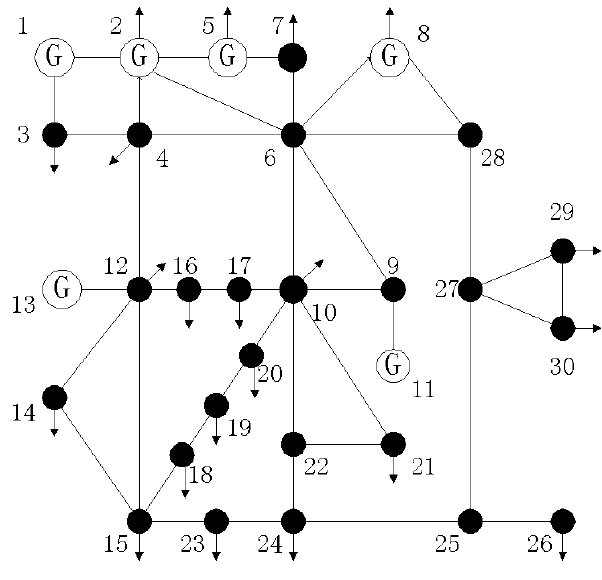
Figure 1. IEEE 30 bus system.